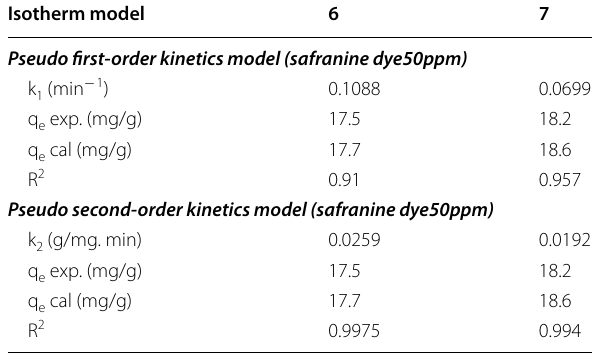
Freundlich model